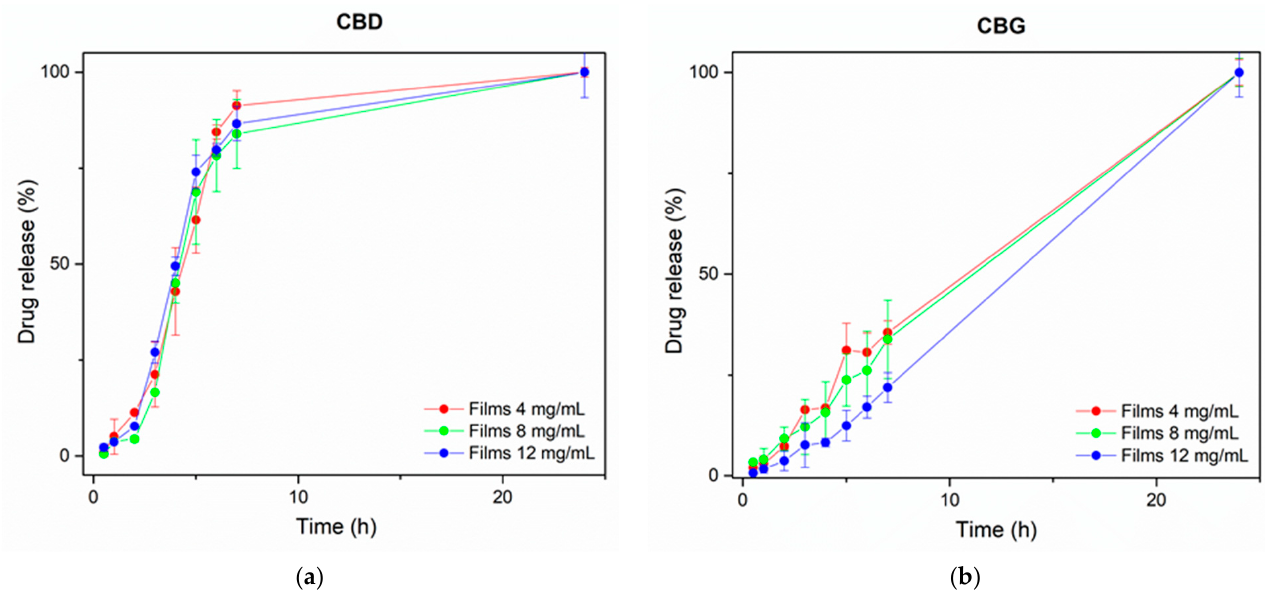
Figure 9. The release profile of ( a ) CBD and ( b ) CBG from the 3D-printed film in PBS pH 7.4 at 37 °C. Each point represents the mean ± SD, n = 3.